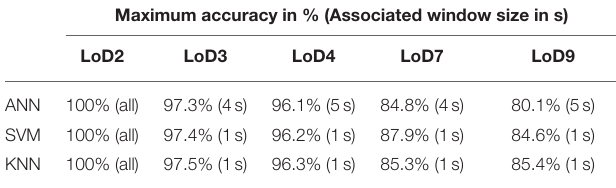
TABLE 3 | Maximum accuracy of each classifiers with associated window